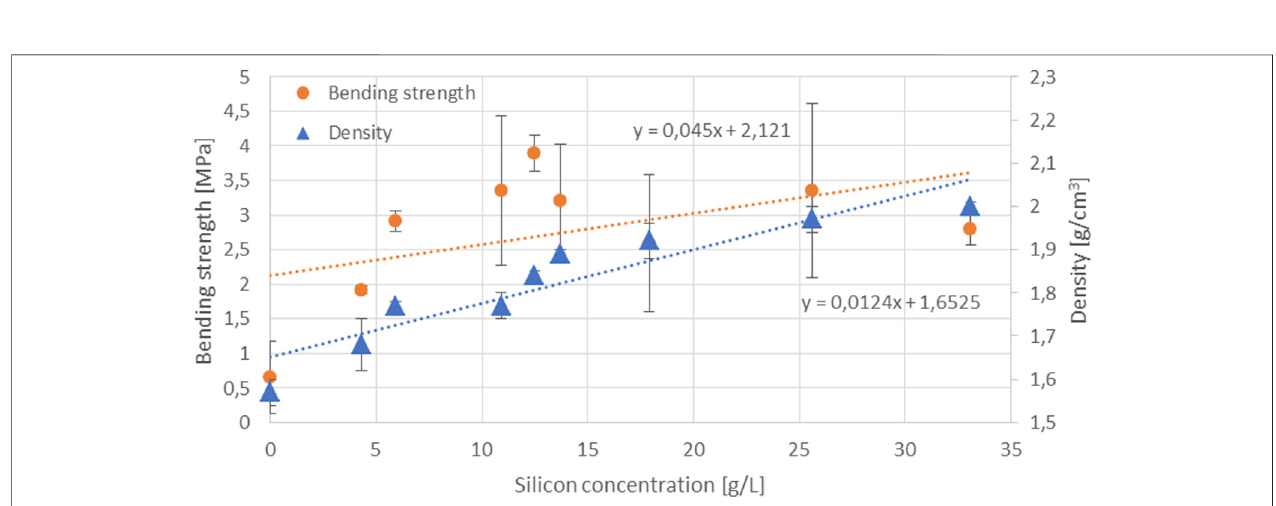
FIGURE4| Bending strength and density ofthe hardened samplesasafunctionoftheSiconcentrationintheAAAs(circlesdenote bending strength and triangles denote density).